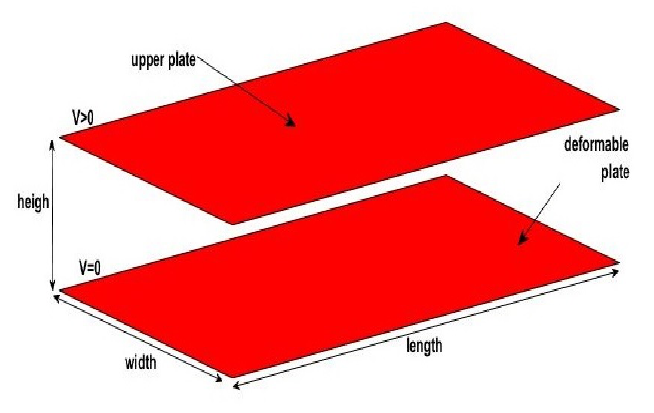
Figure 1. 3 D schematic of the MEMS device with parallel